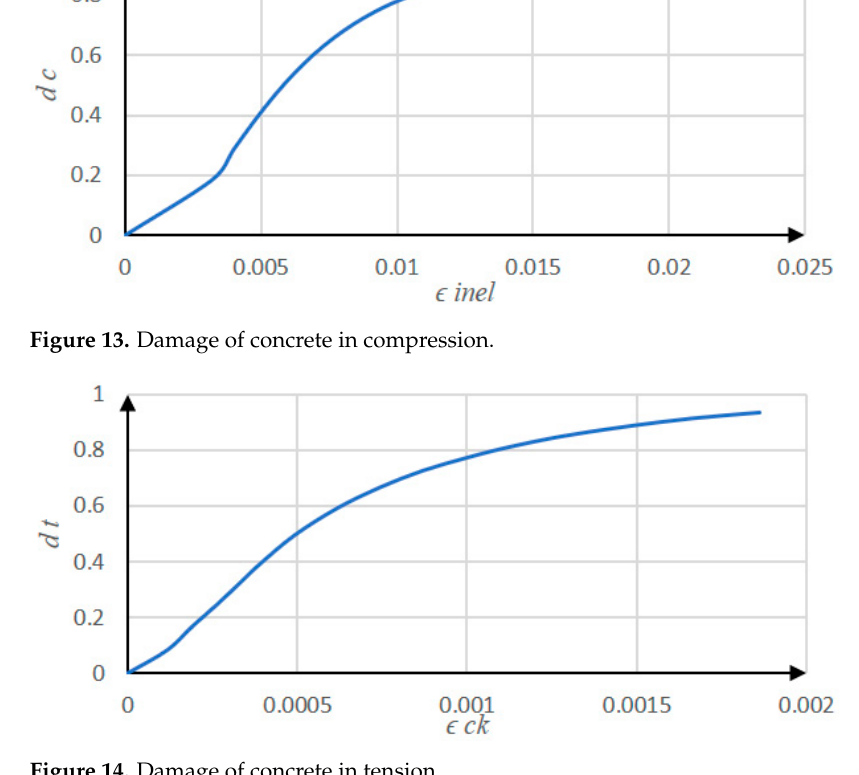
Figure 14. Damage of concrete in tension.